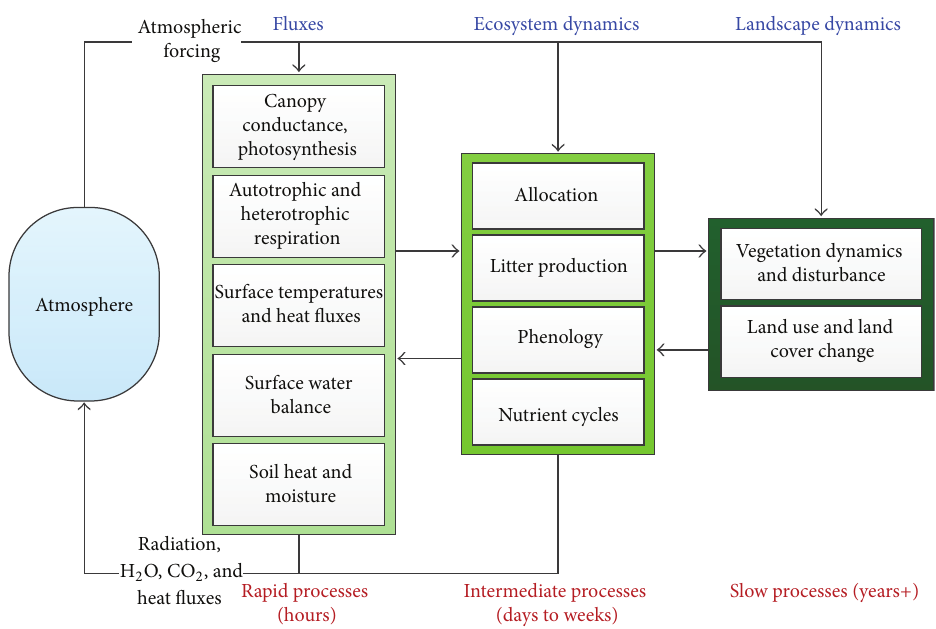
Figure 2: Schematic of a typical land surface model